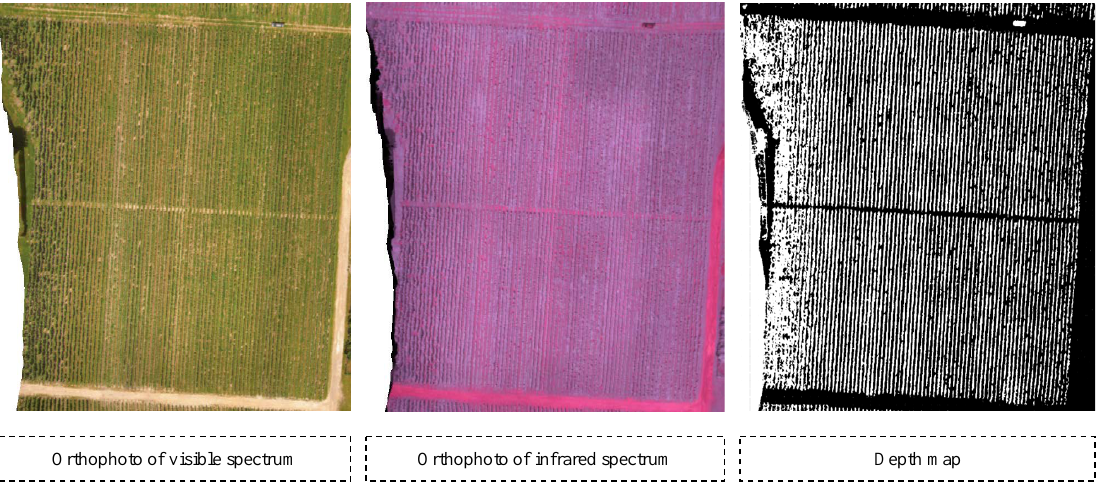
Figure 5. Qualitative results of orthophotos and depth